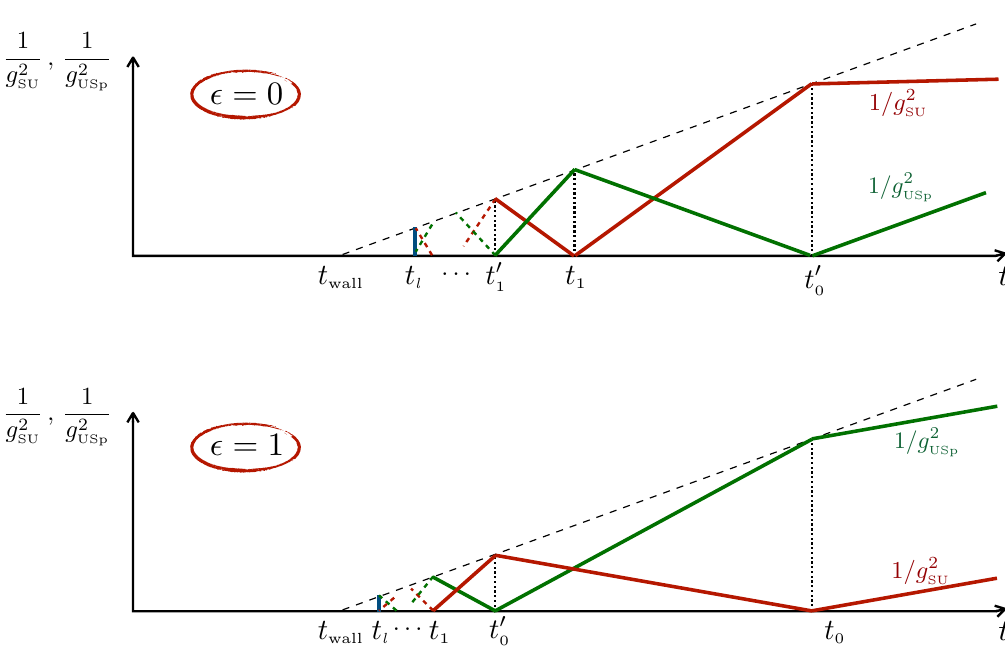
Figure 4 . The di(cid:11)erent behaviors of the gauge coupling running for (cid:15) even and odd, respectively (as prototypes, only (cid:15) = 0 ; 1 are drawn). After the very last step up has been performed, for (cid:15) odd all couplings run the same and are UV-free. For (cid:15) even, one of the couplings stops running, instead (the SU coupling for (cid:15) = 0 and the USp coupling for (cid:15) = 2). The IR behaviors are instead similar. In particular, con(cid:12)nement occurs at t = t l and is always reached before hitting the (would-be) duality